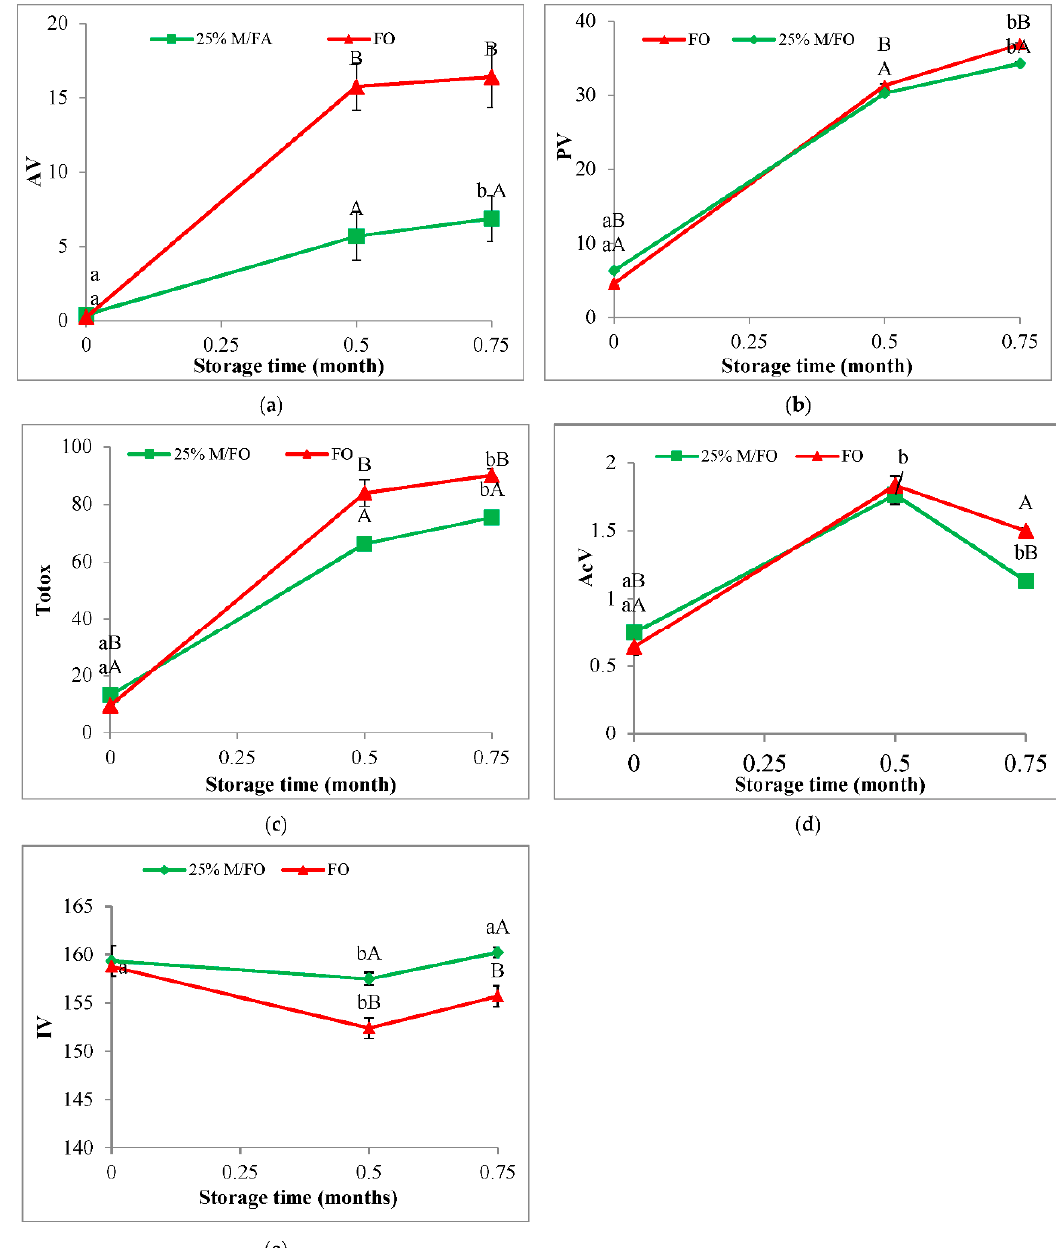
Figure 6. Anisidine value ( a ), peroxide value ( b ), Totox ( c ), acid value ( d ), iodine value ( e ) fish oil with macerate (25% M/FO, green) compared to control fish oil (FO, red) stored at room temperature (20–25 °C). (Values marked with the same lowercase letters a, b differ statistically significantly within the stored samples (25 M/FO or FO), while values marked with different uppercase letters—A, B differ significantly within the same storage time. Analogically values marked with the same letters do not differ statistically significantly, p < 0.05).